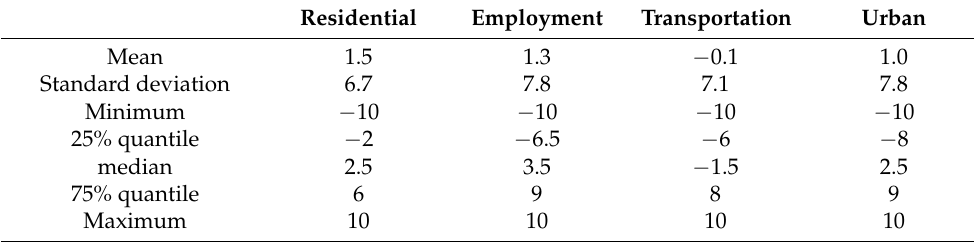
Table 5. Time lag (in years) between population and land use identified by max lag correlation. Residential